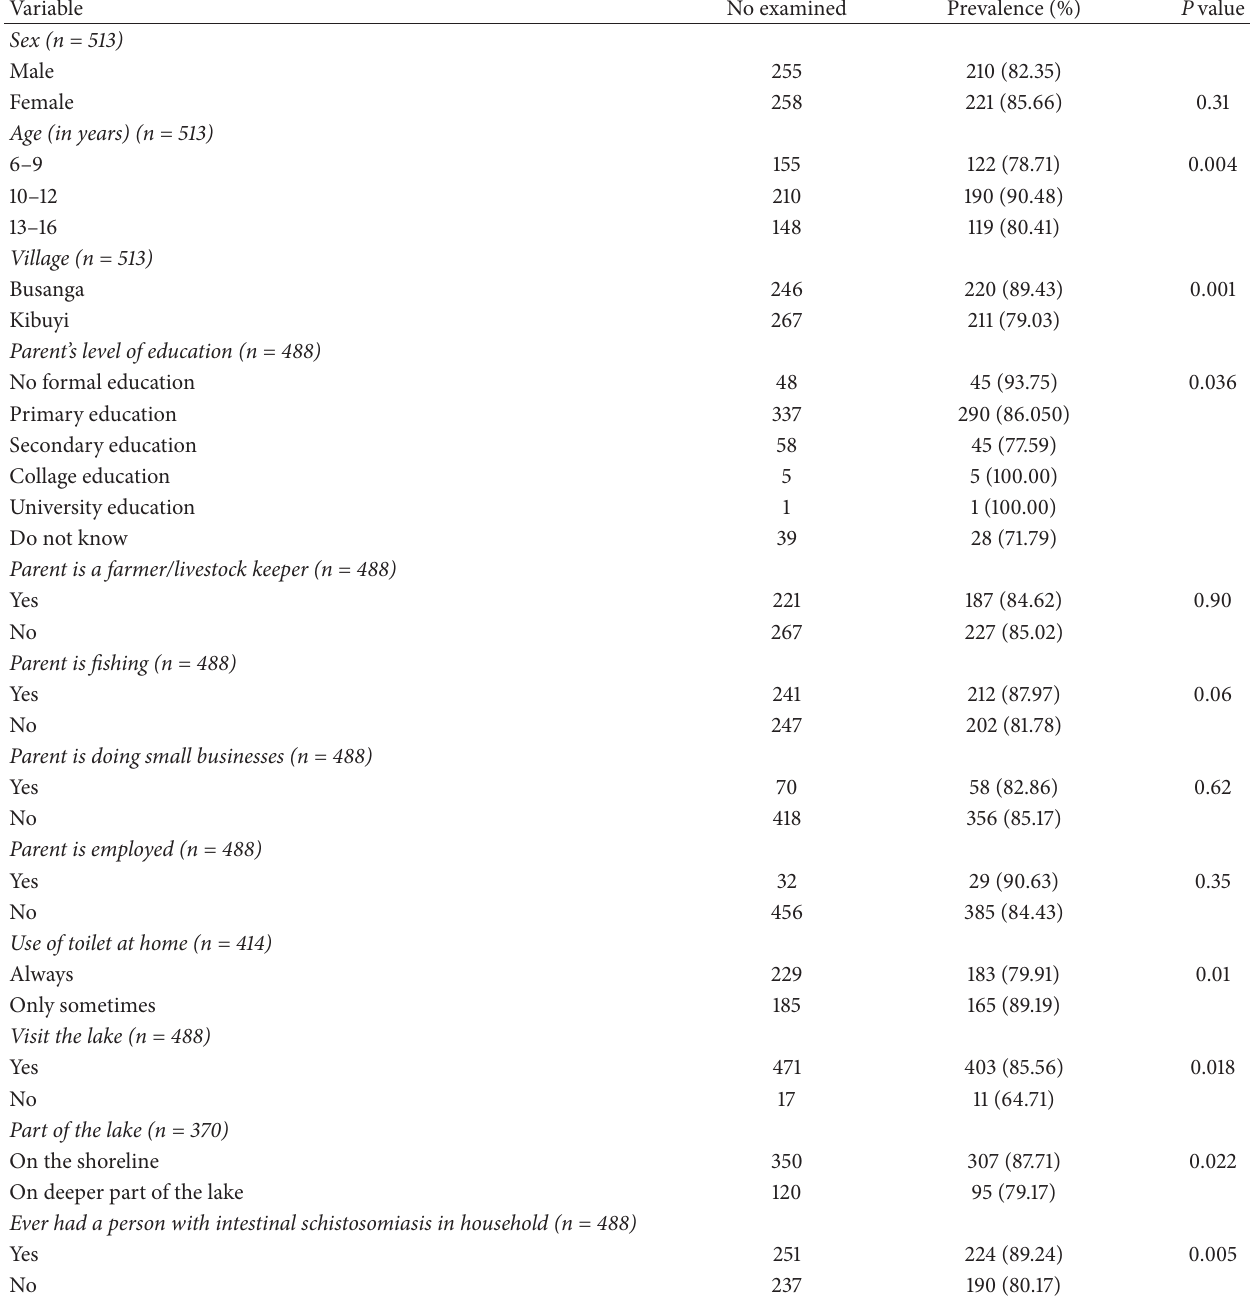
Table 1: Prevalence of S. mansoni stratified by sociodemographic characteristics of study